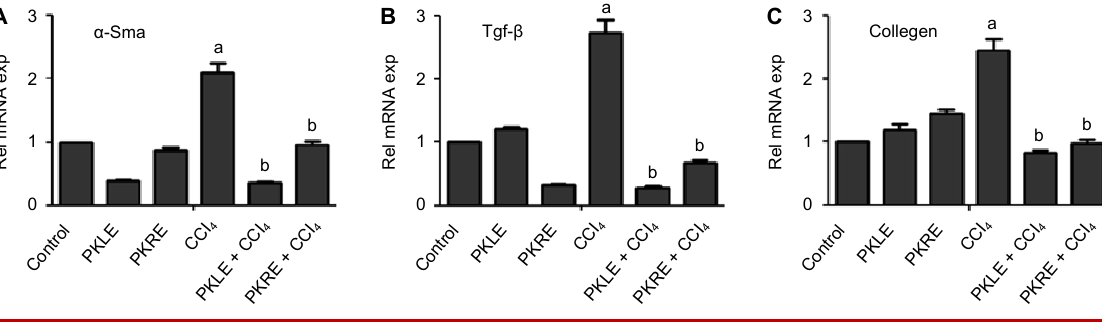
Figure 2 : mRNA expression values of (cid:450) - Smooth muscle actin (A), transforming growth factor- (cid:451) ( B) and collagen (C); Data is rep- resented as Mean ± SD; “a” Shows significant difference Vs Control Group. “b” Shows Significant difference Vs CCl 4